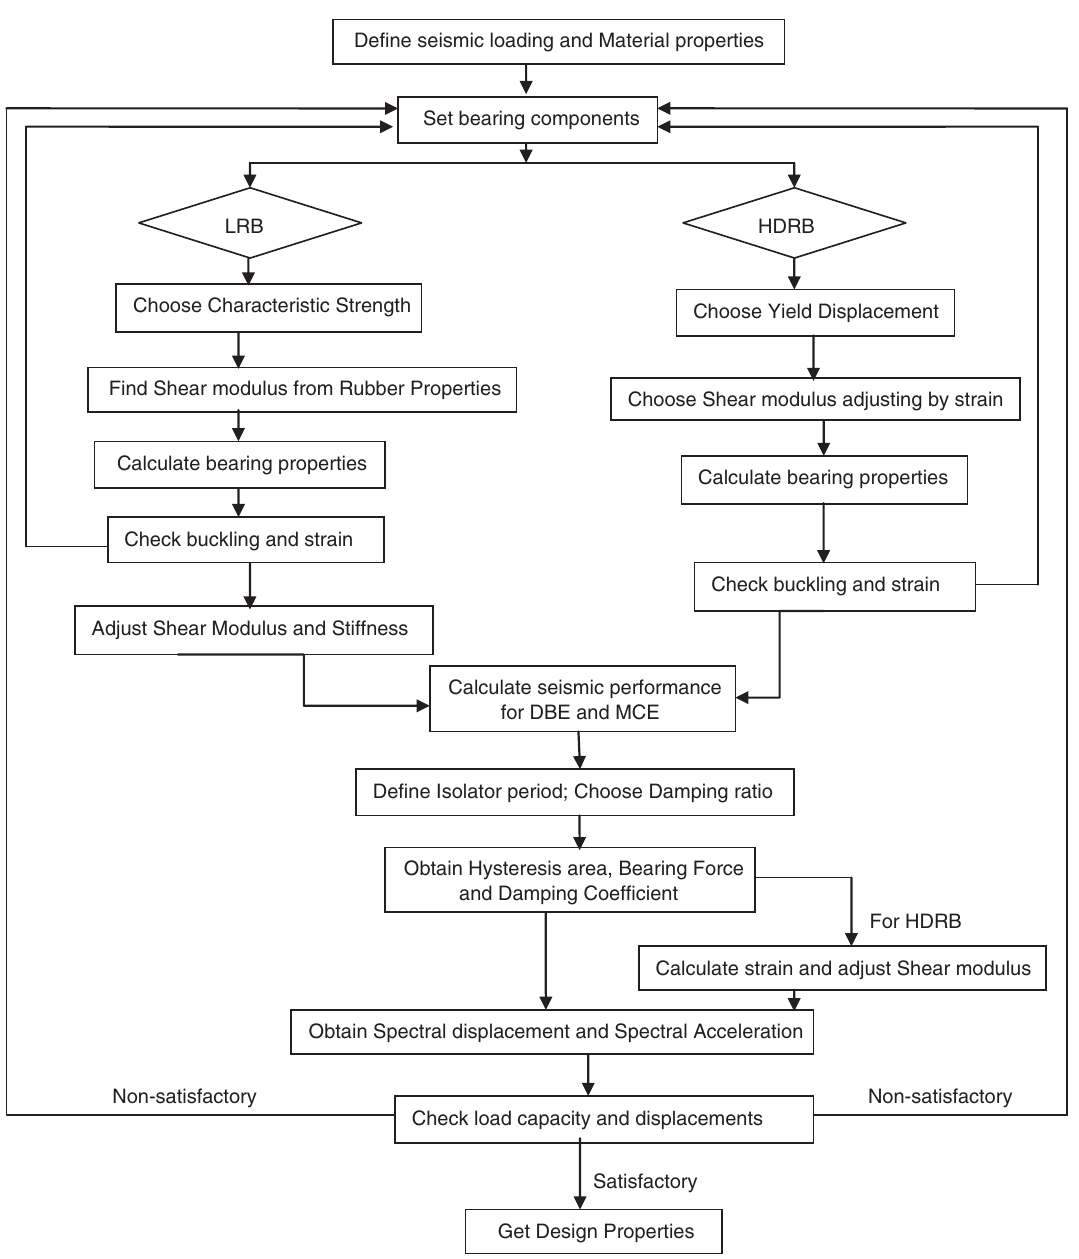
Fig. 2. Design fl ow chart of Rubber-steel